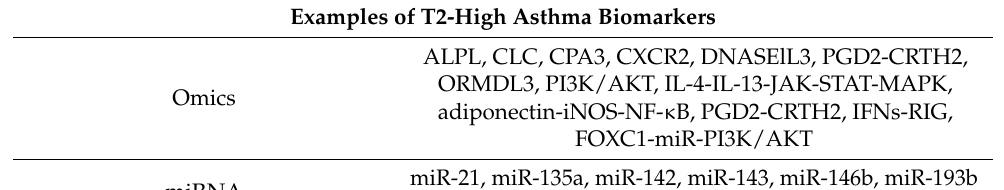
Table 2. T2-high asthma biomarkers.